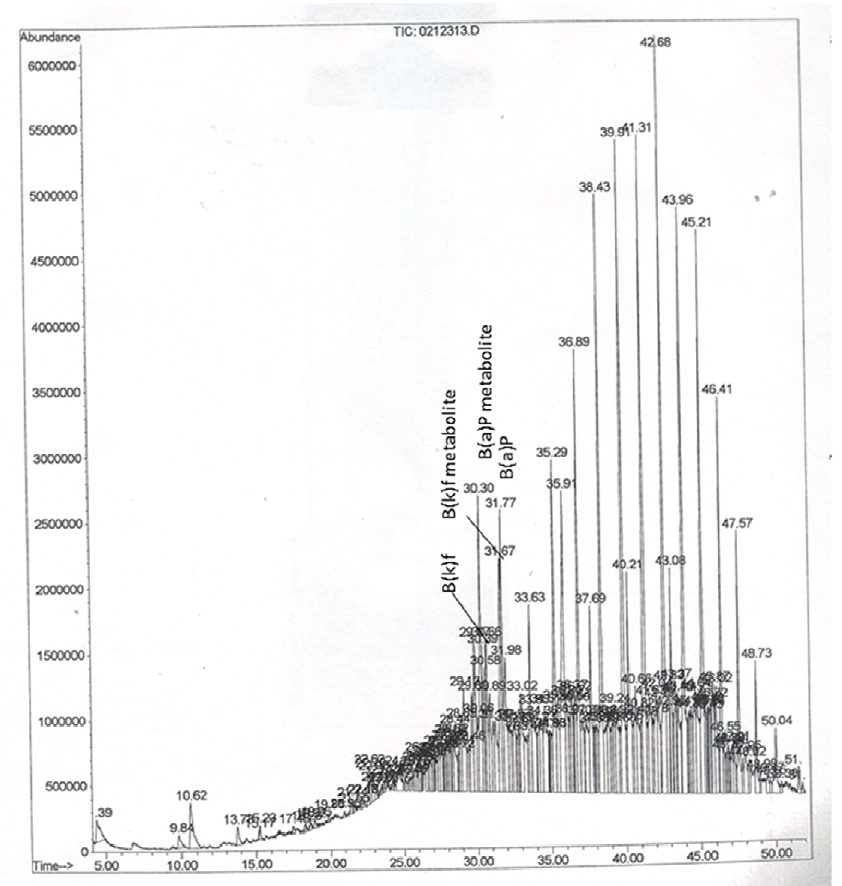
Figure 2. Representative GC-MS chromatogram of PAHs in serum samples of a Caucasian male. The abbreviations are; B(a)P-benzo(a)pyrene, and B(k)f-benzo(k)fluoranthene. Out of 650 postmortem sera samples received for a drug screen, PAHs were detected in 305 samples. Most samples that were positive for PAHs were from children, teens, and adults in their sixties. Very few samples from septuagenarian and octogenarian decedents showed PAHs. The total PAH